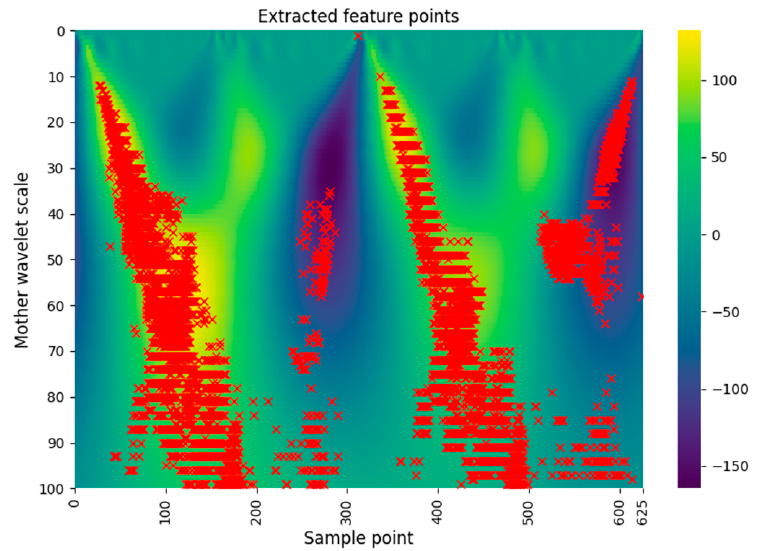
Figure 7. Final feature points of the ATxmega128.